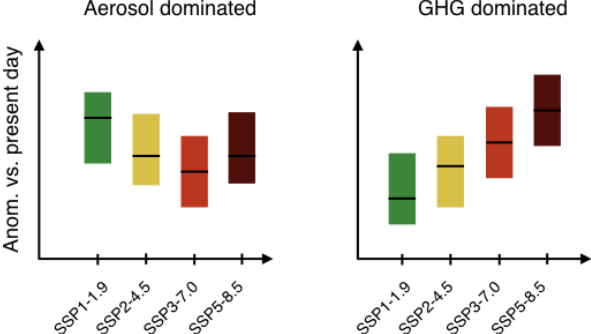
Figure 3. Schematics showing the anticipated pattern of anoma- lies relative to 1980–2014 across the SSPs in cases where the dif- ferences are aerosol-dominated and GHG-dominated, based on the global emission pathways shown in Fig. 1c. Boxes show the in- terquartile range of CMIP6 models; black lines show the median. Significant differences between the SSPs are seen when the median from one SSP falls outside the interquartile range of another. Signif- icant differences between SSPs are not a condition for identification of the respective patterns but may be observed between the extreme scenarios in each